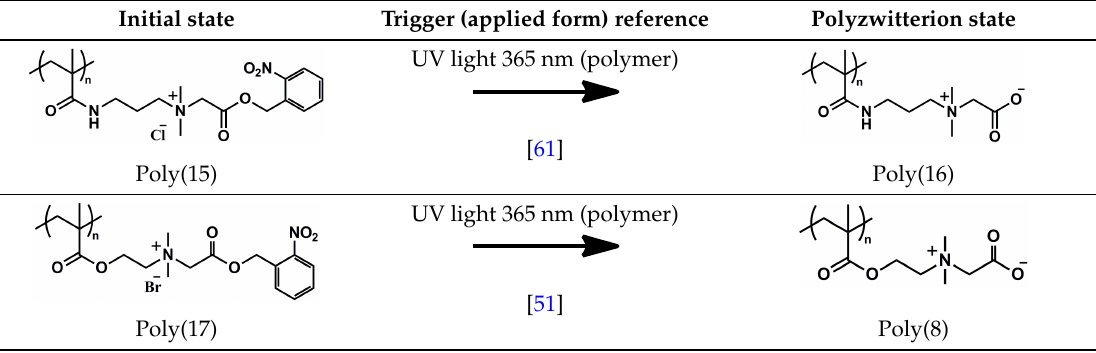
Figure 2. Schematic presentation of spray application of poly(12) as an antibacterial wound dressing hydrogel. Reprinted with permission from Reference [58], Copyright 2011, Wiley-VCH. Similarly, the methacrylic poly(13) analogue to acrylic poly(12), was investigated in hydrogel form prepared by redox polymerization [59]. The hydrogel based on poly(13) inhibited the growth of planktonic bacteria, both Gram-negative E. coli K12 and Gram-positive Staphylococcus epidermidis ( S. epidermidis ), by 99.9% due to the polycationic character as well as by the controlled releasing of SA − as a mild antibacterial agent. After hydrolysis, the hydrogel prevented protein adsorption or bacterial accumulation. Alternatively, covalent attachment of the salicylate molecule as an ester via the phenolic group in a monomer unit poly(14) was developed for enhancing the controlled SA − release over the system with an ionic-forces stabilized SA − in poly(13) [60]. Fabricated hydrogel from poly(14) was prepared redox polymerization. Hydrolysis of the salicylate ester poly(14) was completed in 16 h, while the complete release of the drug SA − from poly(13) was completed in 3 h under the same condition. The hydrogel after the transformation to poly(5) still retained the non-fouling properties for protein and bacteria. 2.1.1.2. Light Trigger Since photolysis is a non-invasive trigger and initiation is timely and spatially localizable, this approach has attracted the greatest interest in bio-related applications. Recently, a photolysis of a photolabile unit for the preparation of switchable polymers poly(15) and poly(16) [51,61] was reported. Their structures are shown in Table 3. In the poly(15) [61] switch to the polyzwitterionic state, poly(16) was enabled via the abstraction of a photolabile o -nitrobenzyl-carboxymethyl pendant during irradiation at 365 nm in PBS solution. In the polycationic state, poly(15) was able to bind double-strand DNA (dsDNS), showing the size of the DNA complex of 170 nm in solution and on a dextrane-modified surface. Upon irradiation at 365 nm, the polyzwitterionic state poly(16) was formed and the dsDNA was released in solution as well as from the surface [61]. In addition, dramatic differences in polycationic poly(15) and the